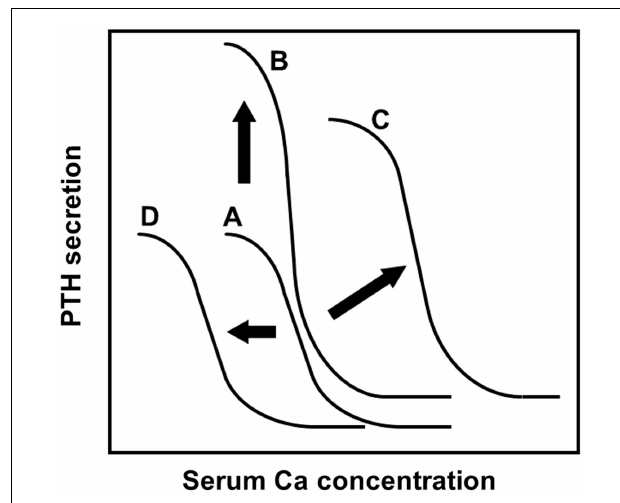
FIGURE 2 |The sigmoidal curve of the PTH-Ca relationship, modified from a previous report (Imanishi, 2002). The analyses of PTH secretions inhibited by extracellular Ca in vitro revealed the sigmoidal relationship of the PTH-Ca relationship. Setpoint, the Ca concentration causing half-maximal inhibition of PTH secretion, is an indicator of sensitivity of parathyroid cells to extracellular Ca by CaR. (A)The relationship in healthy subjects was fitted to a symmetrical sigmoidal curve. (B)The normal sigmoidal curve will shift upward when the secretory cell number is increased, without changing its setpoint. (C) An altered sigmoidal curve is observed in human parathyroid adenomas, refractory SHPT, by changing the setpoint to the right. In the case of severe setpoint shift, PTH secretion is persistent even at high Ca concentration: so-called “autonomous” PTH secretion. An altered PTH-Ca relationship was also observed in PTH-cyclin D1 transgenic mice (Imanishi et al., 2001, 2009a). (D) Administration of cinacalcet or activating mutation of CaR observed in autosomal dominant hypocalcemia increases the CaR sensitivity to serum Ca. Activations of CaR result in the PTH-Ca relationship curve moving to the